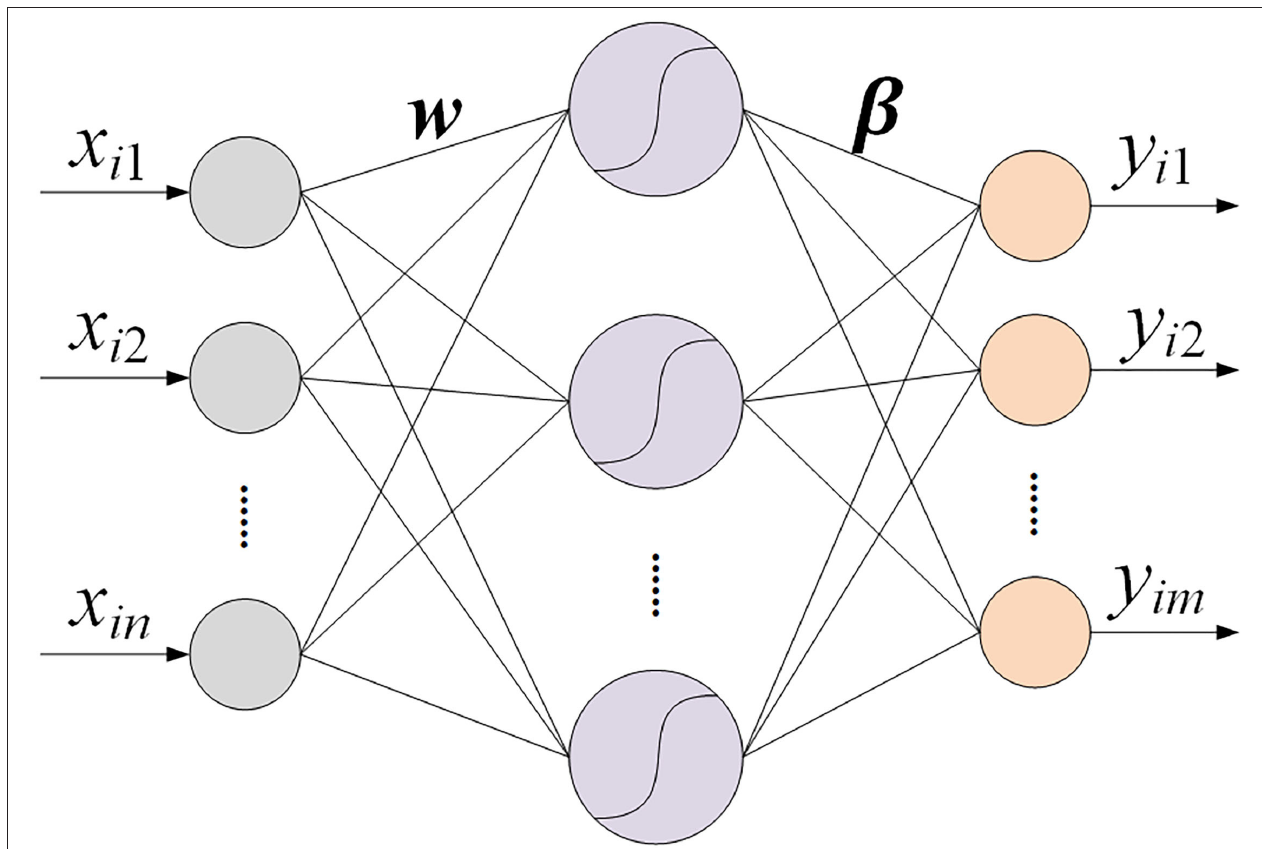
FIGURE 4 | The structure of